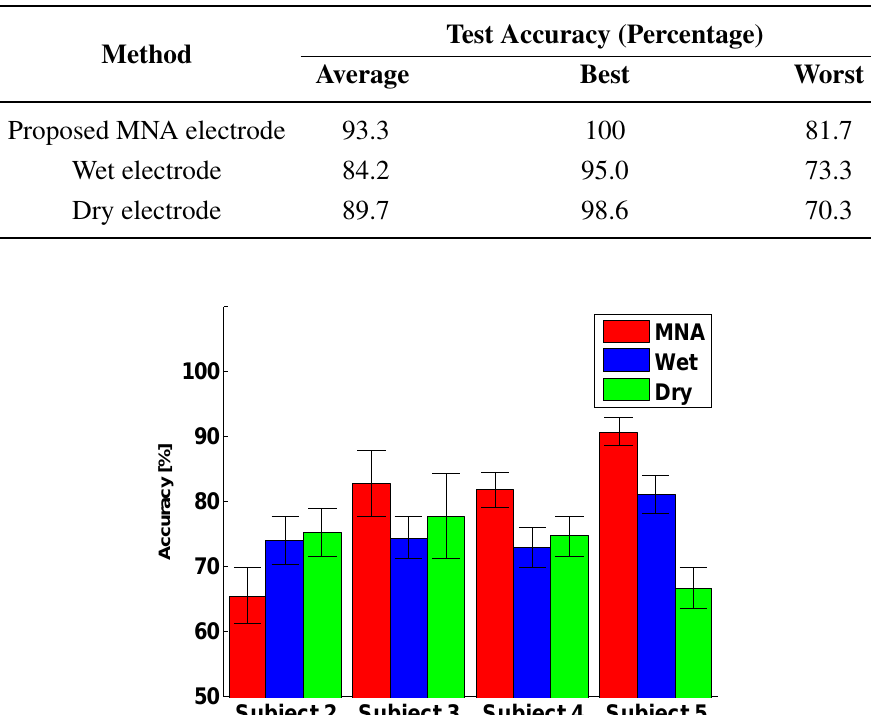
Table 2. Thumb motion classification accuracy (Subject 1).